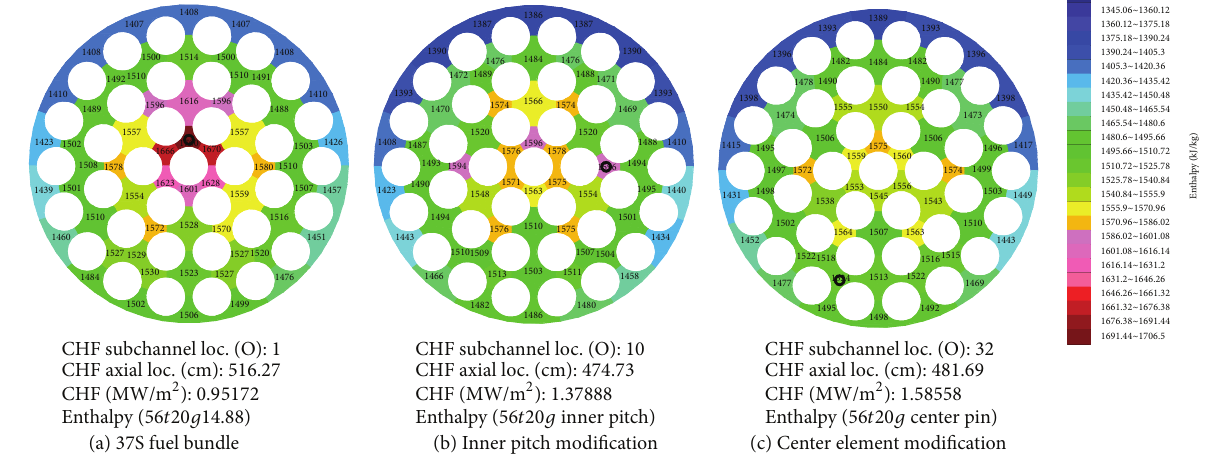
Figure 8: Enthalpy distributions of the standard 37-element fuel and its modifications for 256 ∘ C.